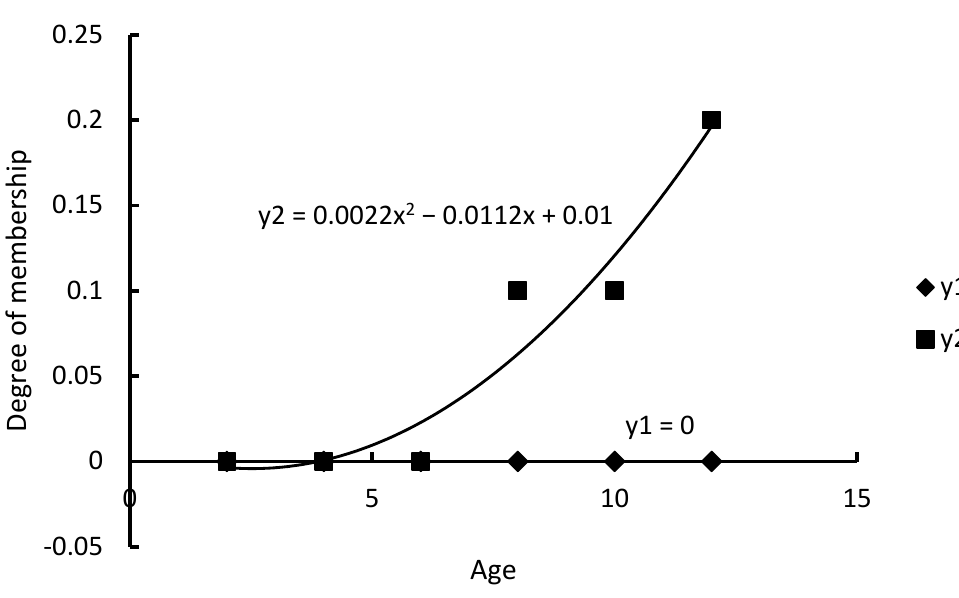
According to the existing statistical data, the fitting results of y 1 and y 2 are shown in Figure 1, where y 1 = 0, y 2 = 0.0022 x 2 − 0.0112 x + 0.01. Then, y 3 = − 0.0022 x 2 + 0.0112 x + 0.99 can be calculated by Equation (7).